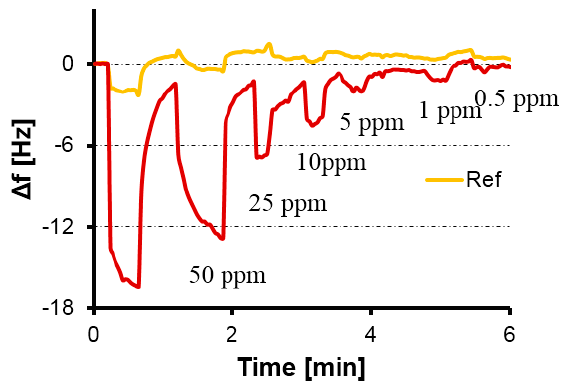
Figure 6. QCM responses of MIP nanoparticles (NPs) containing allyl amine towards formaldehyde at 50% rH.